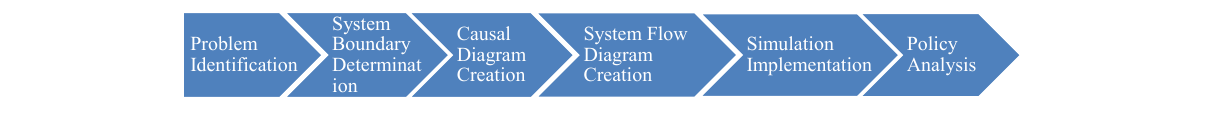
FIGURE 3 | System dynamics